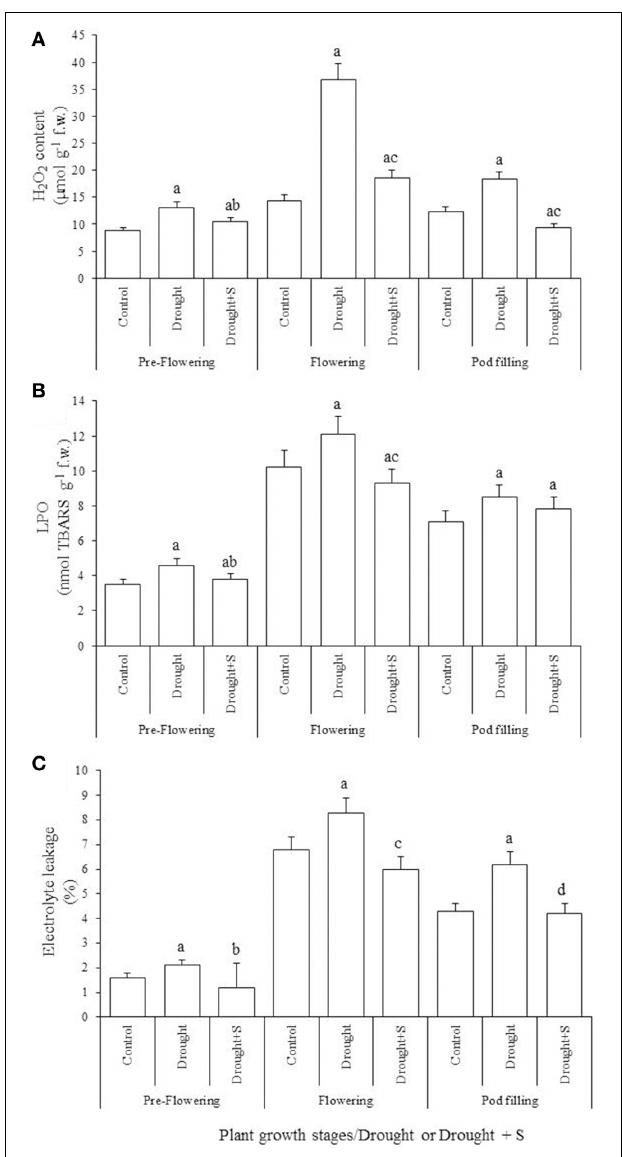
FIGURE 1 | Levels of H 2 O 2 (nmol g − 1 fresh weight, f.w.) (A), lipid peroxidation (LPO; nmol thiobarbituric acid reactive substances, TBARS g − 1 f.w.) (B) and electrolyte leakage (%) (C) in the mungbean ( Vigna radiata ) leaf as influenced by drought stress and by drought + sulfur (S) application (mg kg − 1 soil) at pre-flowering, flowering, and pod-filling stages of plant growth. Values are the means of five replicates ± standard deviation. Significant differences within the same growth stage are: a vs. Control; b vs. Drought (pre-flowering); c vs. Drought (flowering); and d vs. Drought (pod-filling).